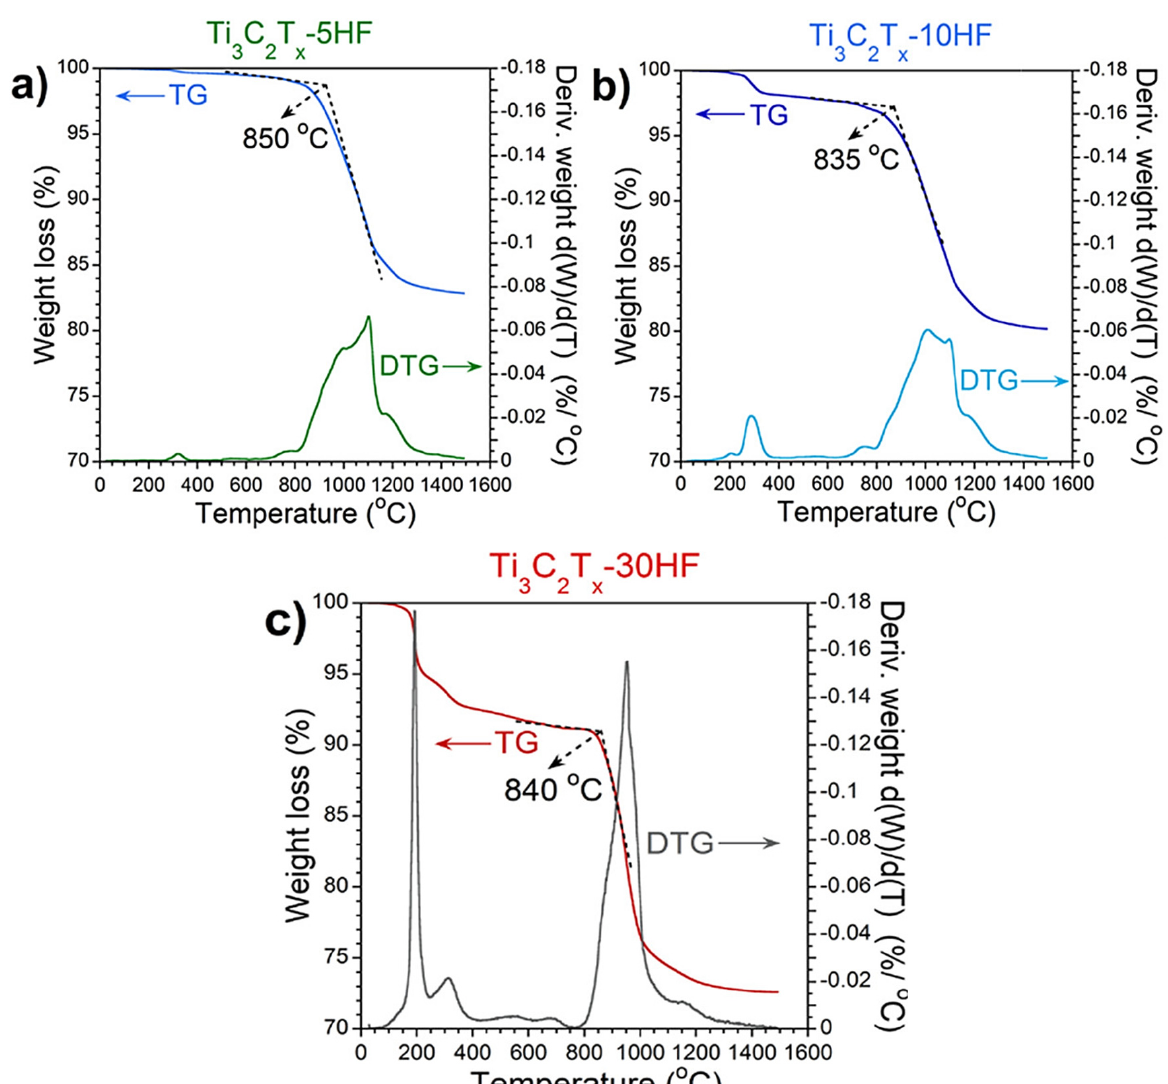
Figure 9. Thermal gravimetric (TG) plots with derivatives (DTG) for MAX powder etched with ( a ) 5 wt% HF, ( b ) 10 wt% HF, and ( c ) 30 wt% HF [34]. Copyright 2019, American Chemical Society.